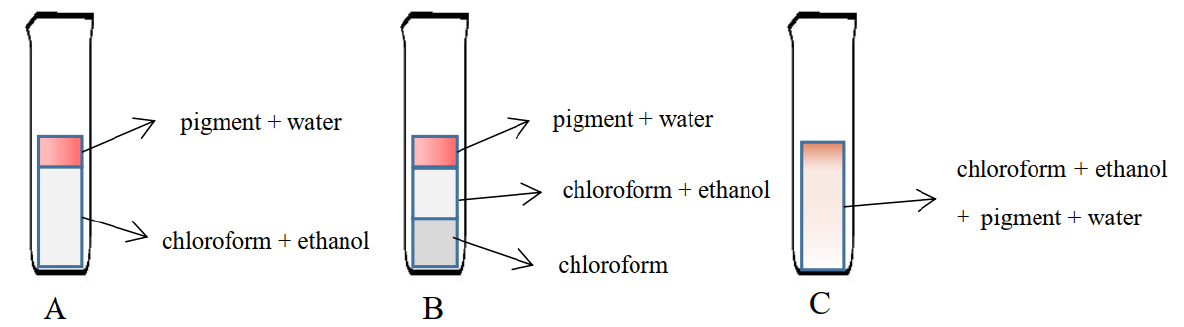
Figure 1. Schematic diagram of the purifying pink pigment with different ratios of the leaching agent and extractant. ( A ) indicates chloroform and anhydrous ethanol ratios close to 1:1; ( B ) indicates chloroform and anhydrous ethanol ratios greater than 1:1; ( C ) indicates chloroform and anhydrous ethanol ratios less than 1:1.